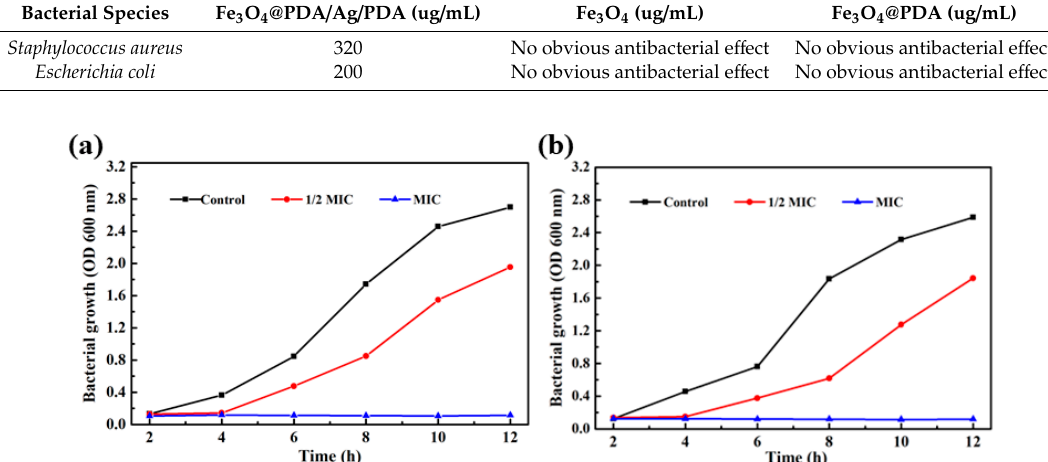
ff erent concentrations of